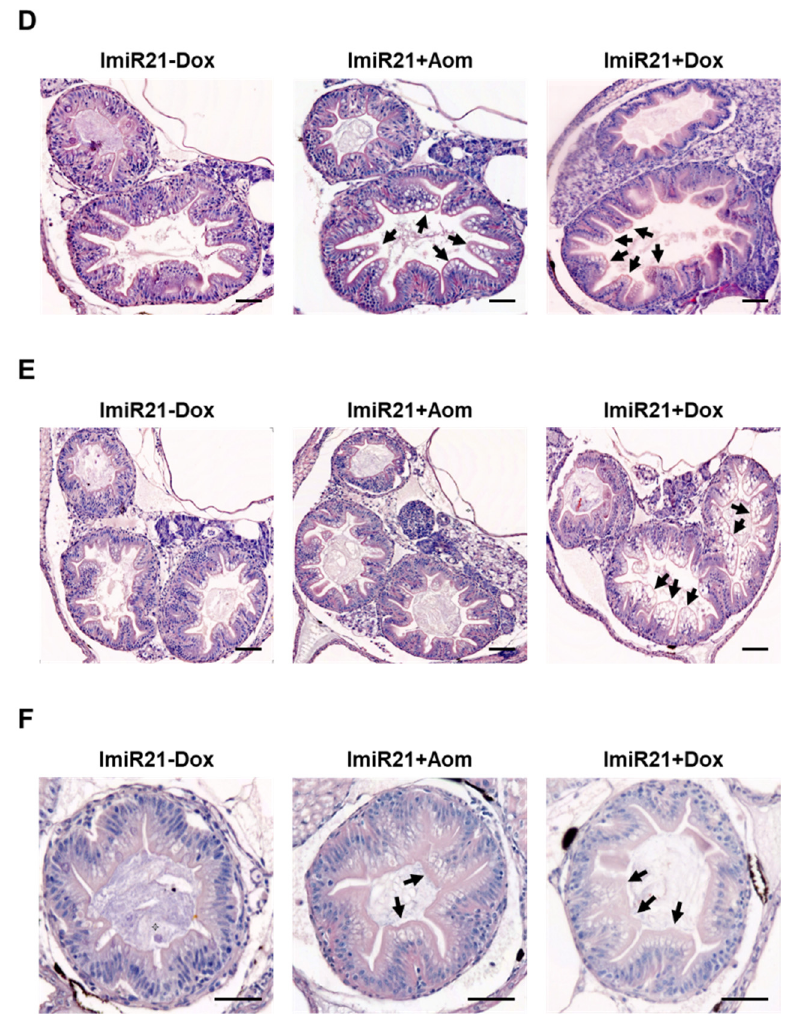
Figure 4. Characterization of inflammatory bowel disease (IBD)-like phenotype in ImiR-21. ( A ) Rep- resentative images of whole-mount alcian blue staining of WT + Dox, ImiR-21 ± Dox, and ImiR-21 + AOM at 21 days post-fertilization (dpf). Blue signals are the stained goblet cells in the injured villus of the posterior intestine of ImiR-21 + AOM and ImiR-21 + Dox animals under inflammatory conditions. Scale bar: 200 μ m. ( B ) Schematic diagram of the intestinal structure of zebrafish. H&E-stained transverse plane sections in different parts of ImiR-21 ± Dox and ImiR-21 + AOM intestines (21 dpf) (intestinal bulb, mid-intestine, and posterior intestine are corresponded to panels ( C – F )). Goblet cell hyperplasia is indicated by arrows. Scale bar: 50 μ m.